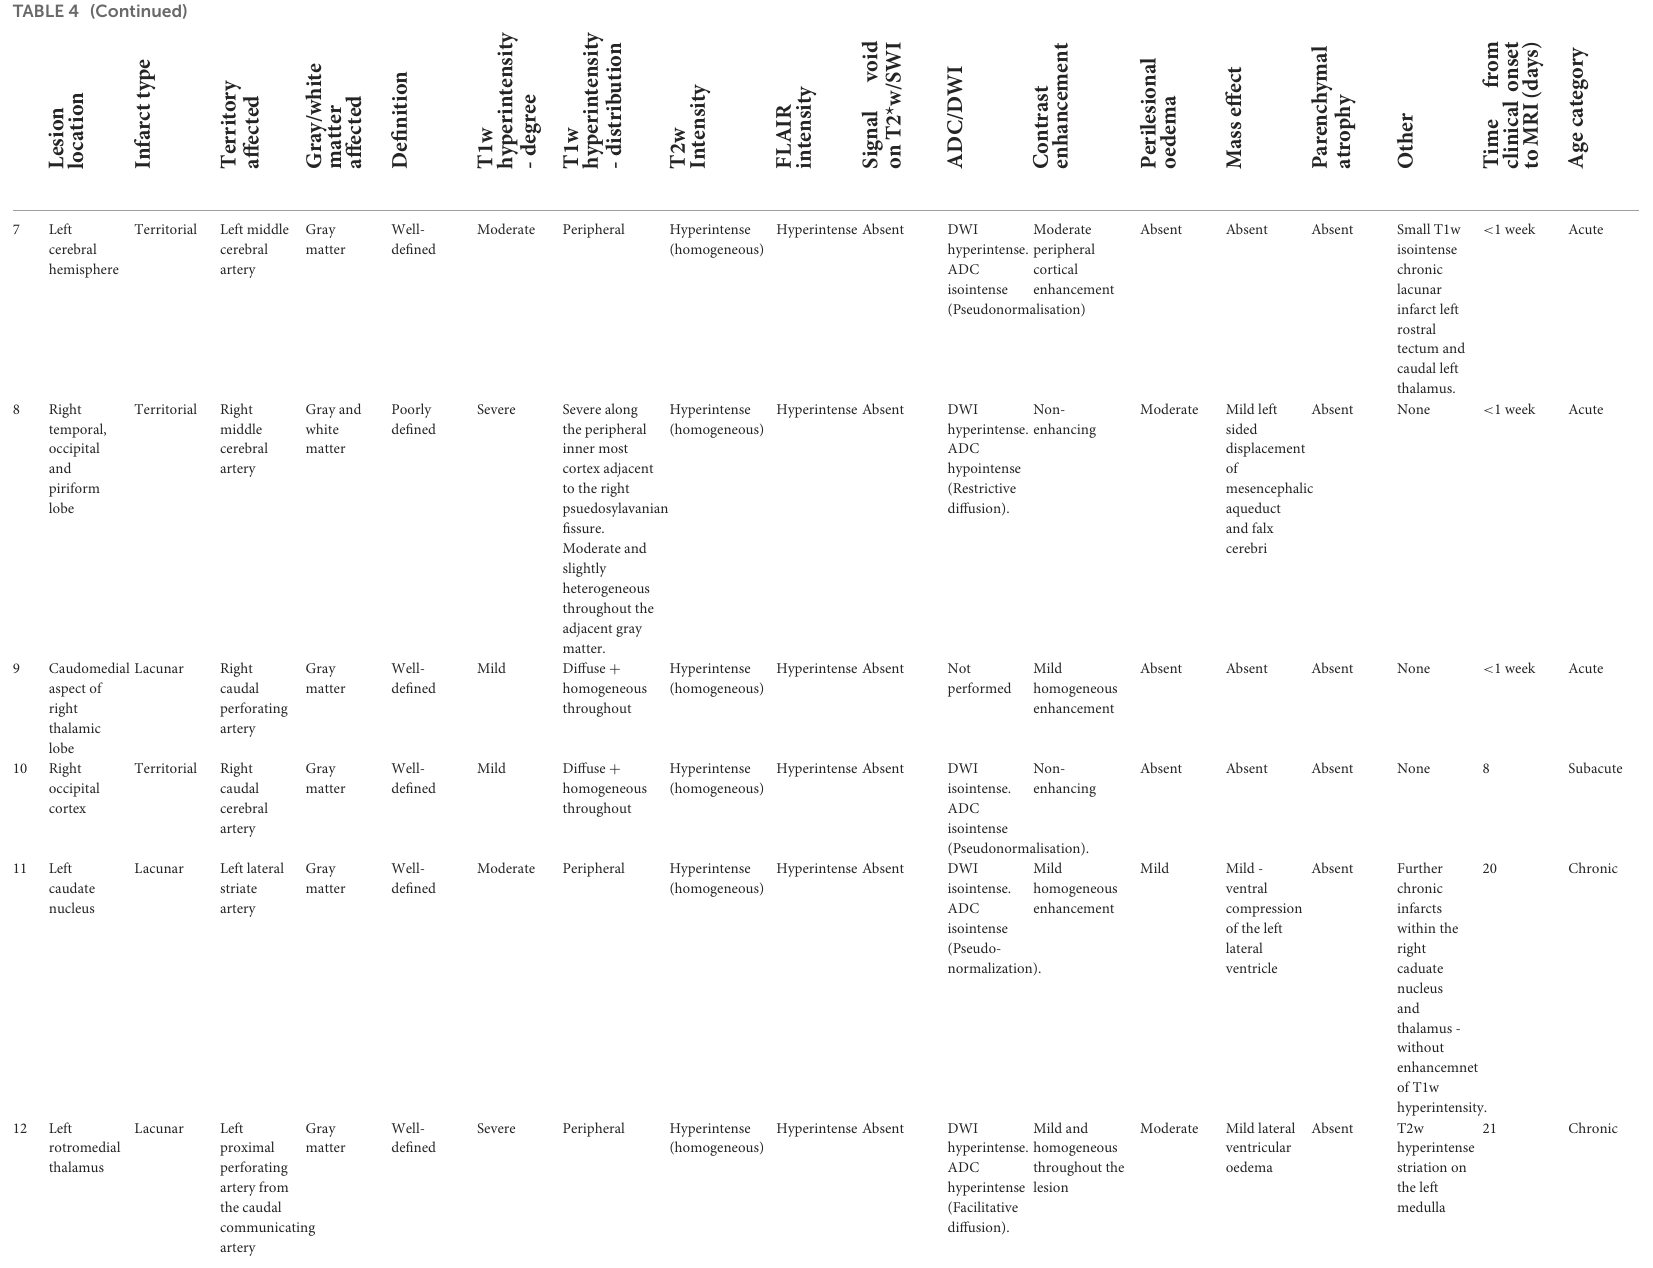
thecaudal communicating artery